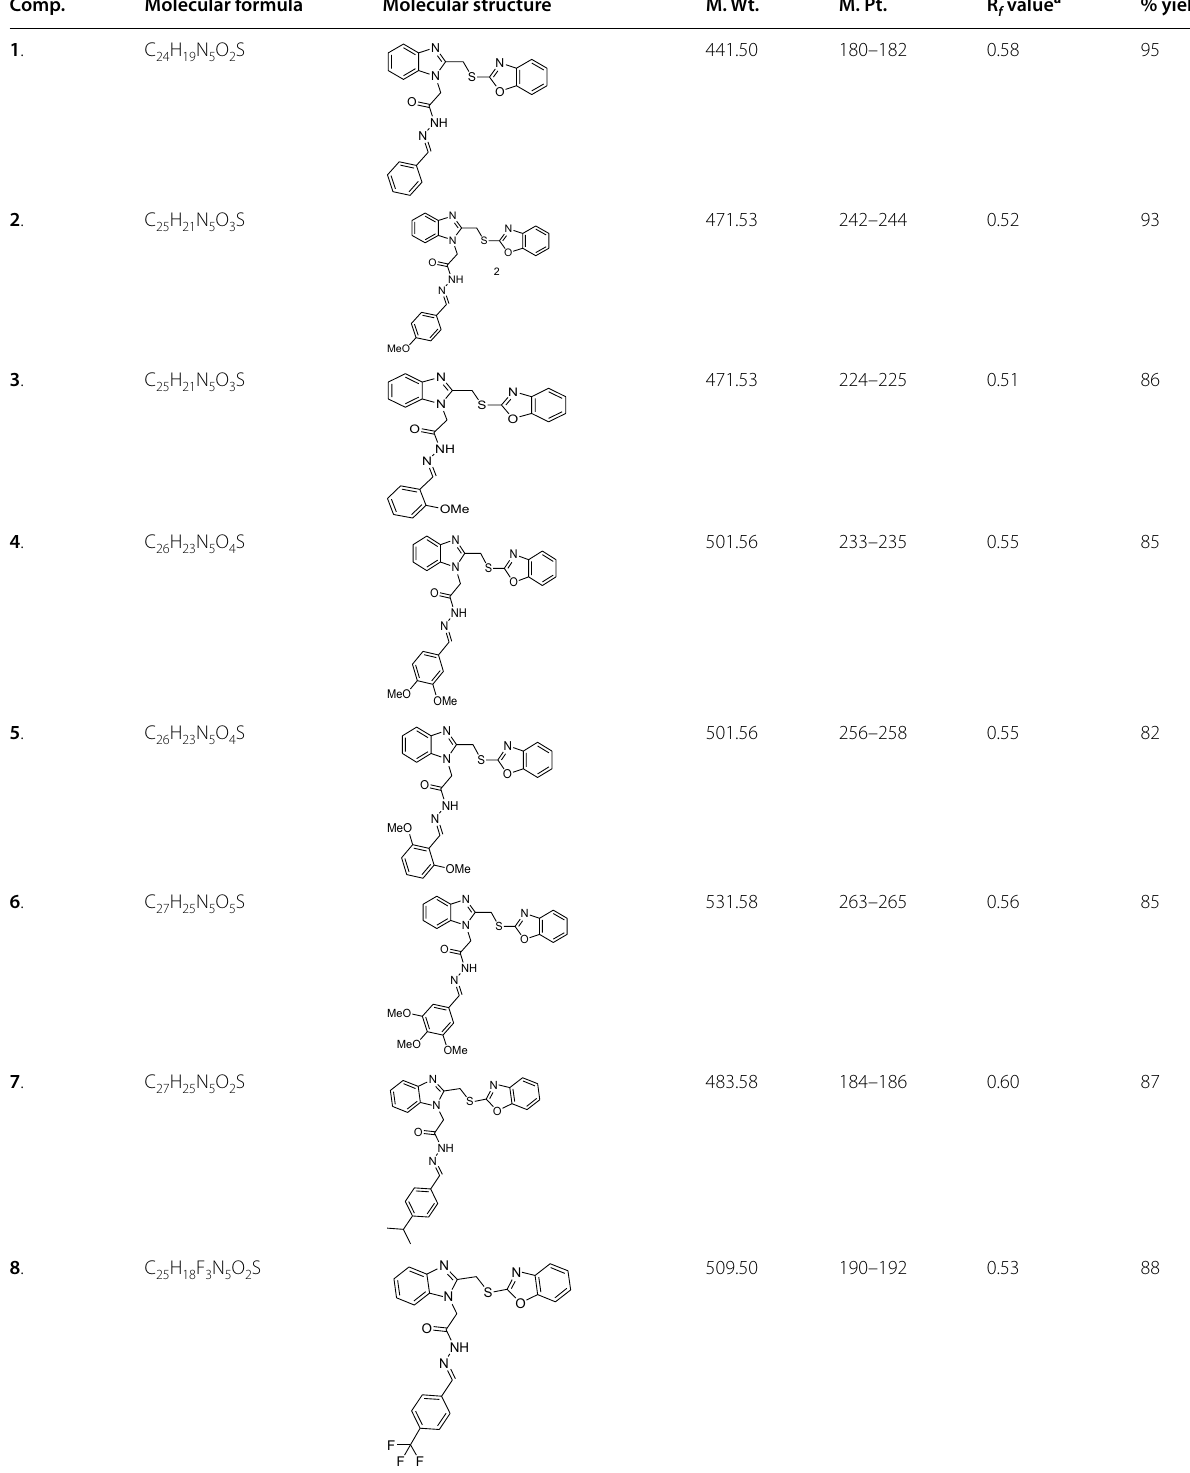
Table 1 The physicochemical properties of synthesized benzoxazole derivatives (1–26)